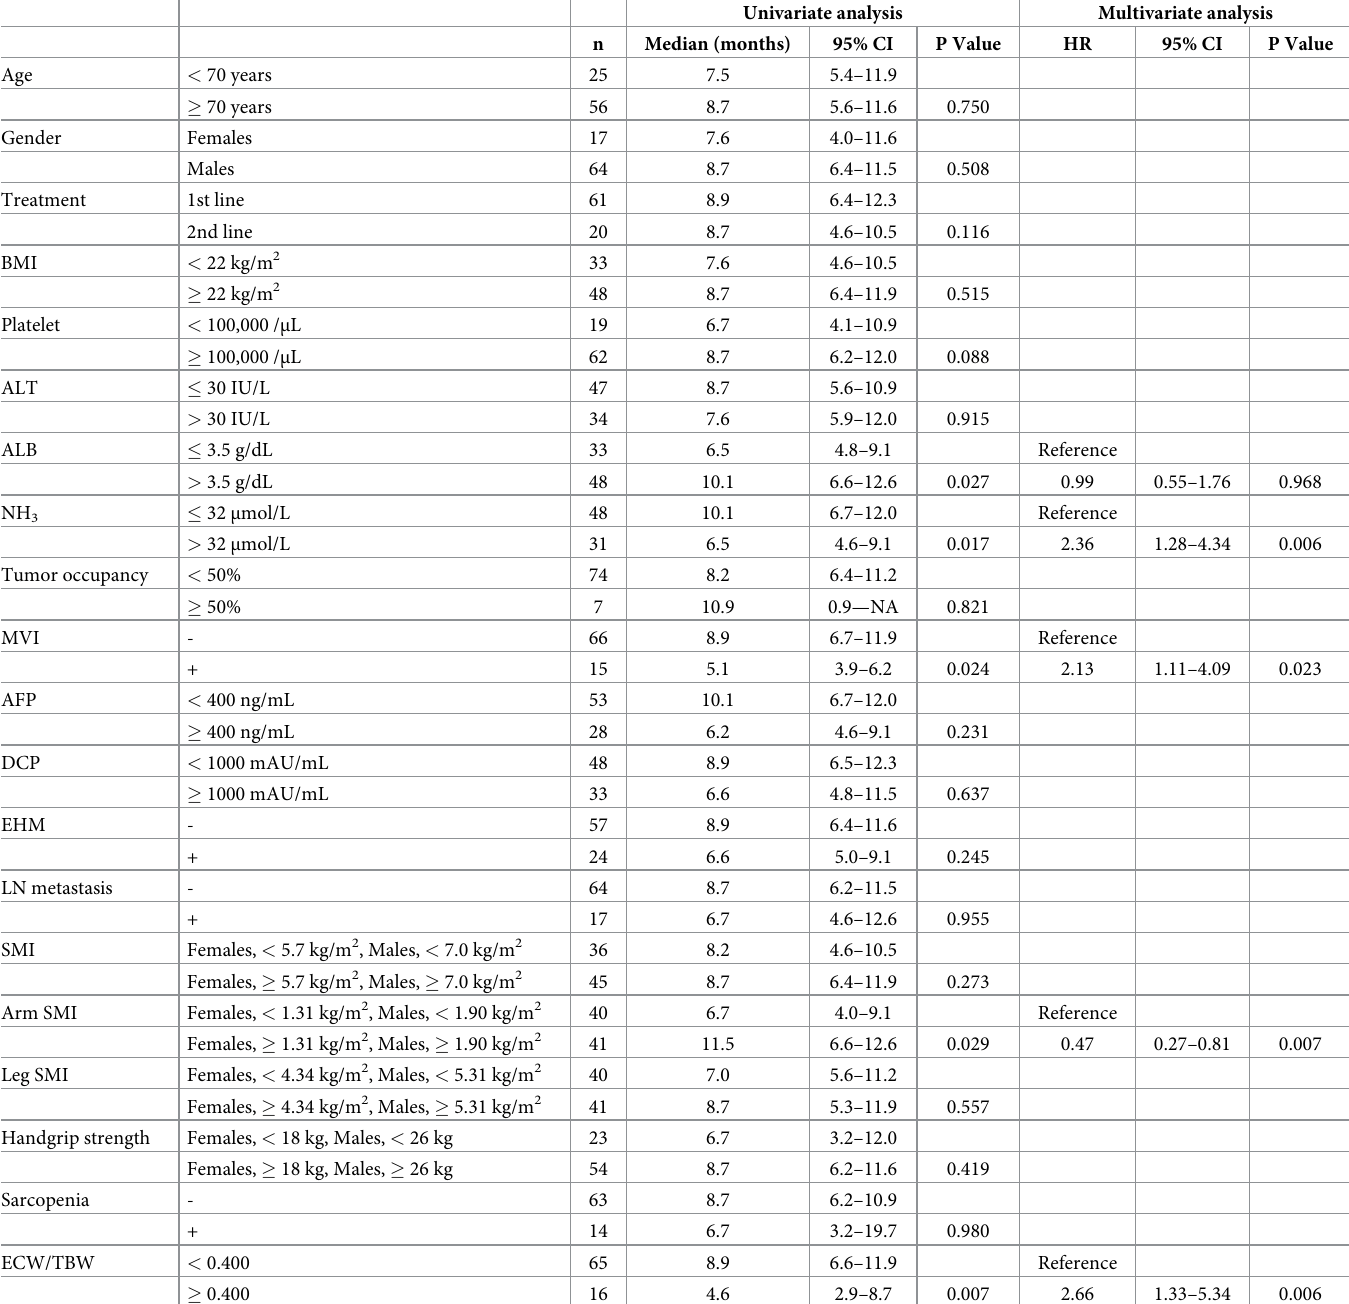
Table 3. Factors associated with progression free survival treated with